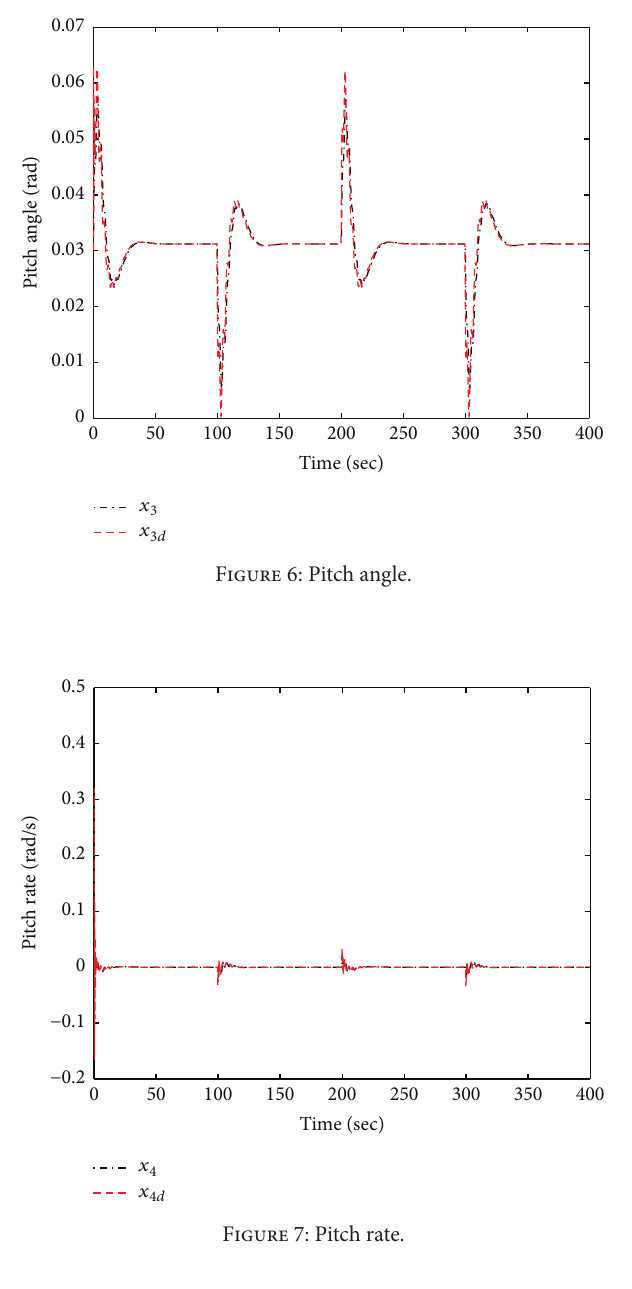
Figure 6: Pitch angle.